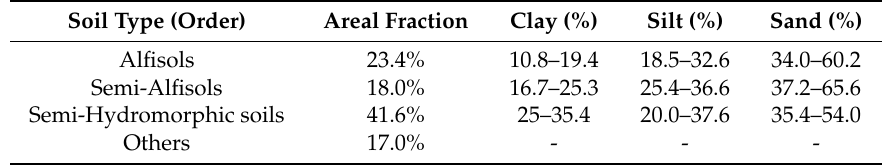
Table 1. The main soil types and their soil separates in Henan. Soil particles are grouped according to their size into what are called soil separates (clay, silt, and sand). The soil diameter limits for clay, silt, and sand are less than 0.002 mm, 0.002–0.02 mm, and 0.02–2 mm,